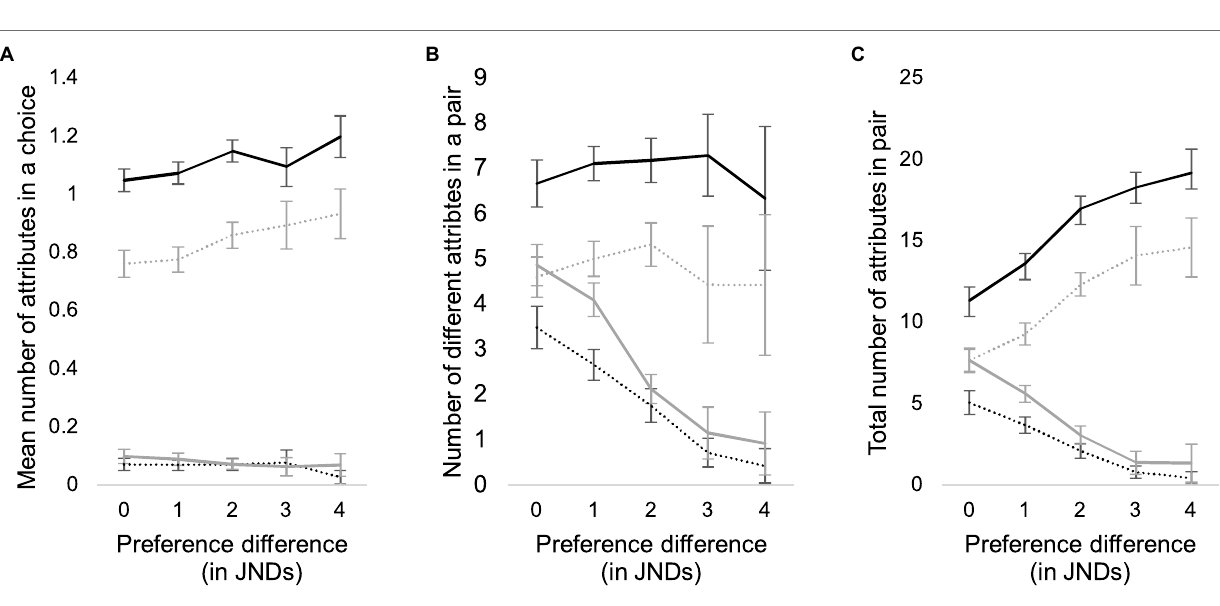
FIGURE 3 | Mean number of attributes that participants used in each pair according to their quality difference (A) , number of different attributes that participants used (B) , and total number of reasons given in each pair (C) . Black lines represent the number of chosen alternatives, gray lines the number of rejected alternatives, and solid lines and dashed lines the positive and negative attributes,